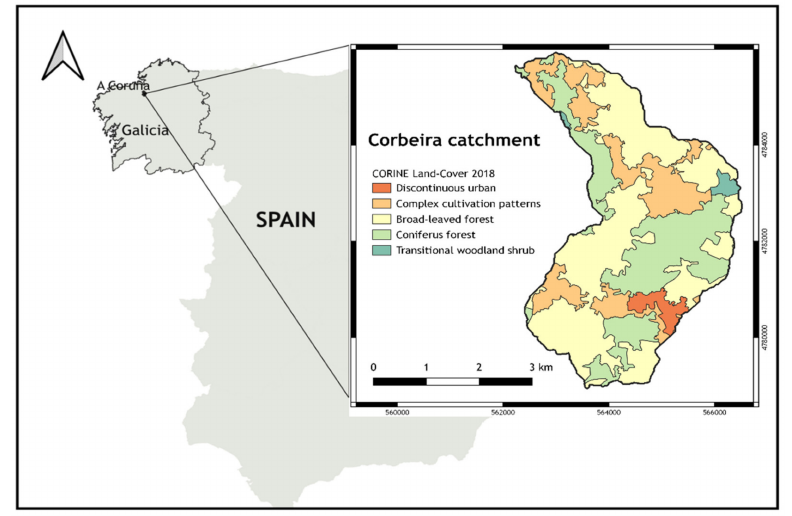
Figure 1. Geographic location and main types of land use within the headwater of the Corbeira